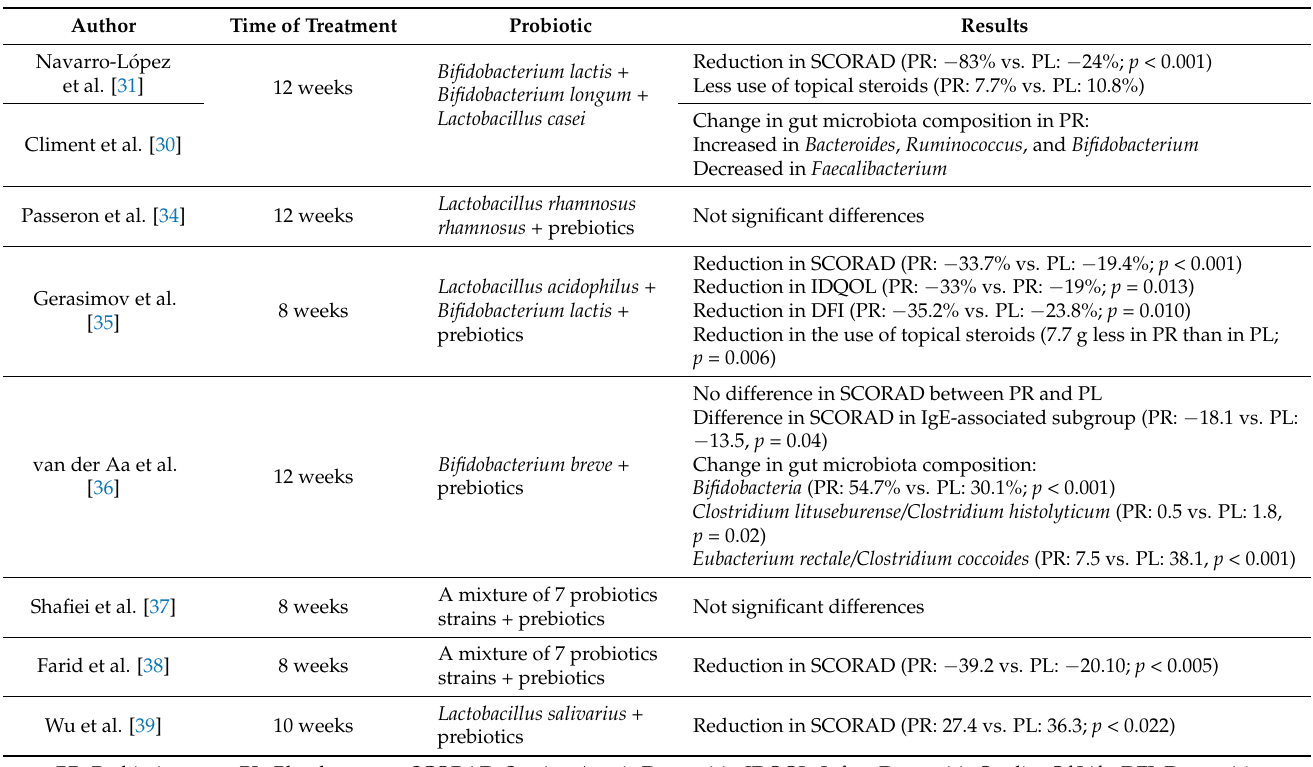
Table 1. Probiotics and atopic